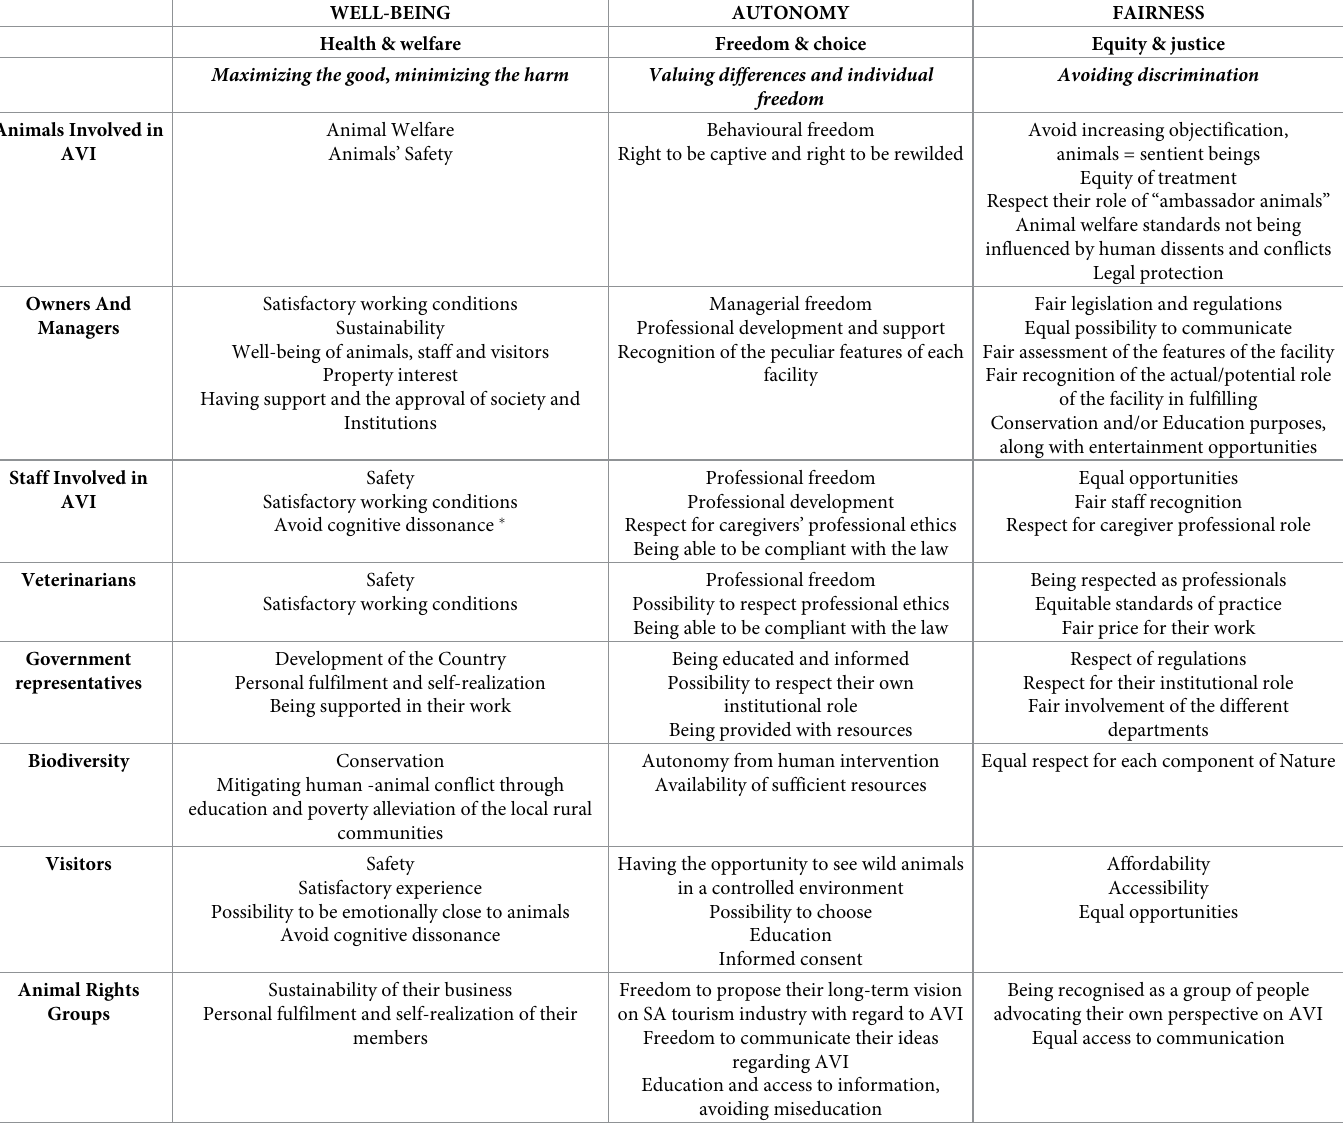
Table 7. Customized final